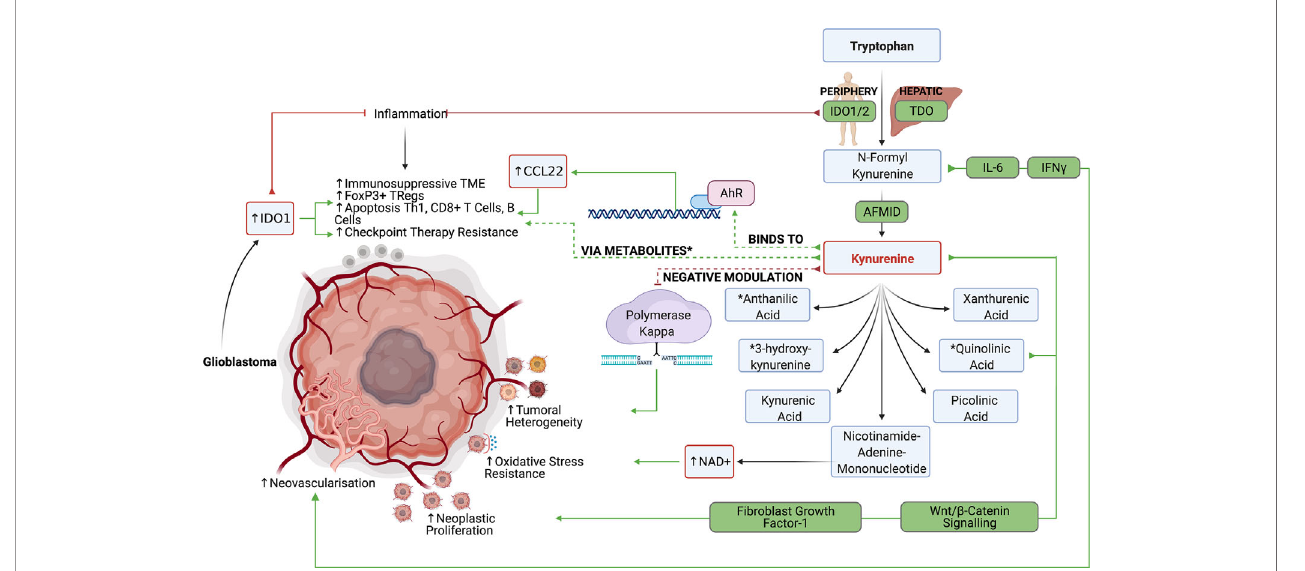
FIGURE 3 | The IDO1/2 and TDO pathway allow the production of various tryptophan metabolites, which suppress anti-glioblastoma lymphocyte responses while promoting tumor